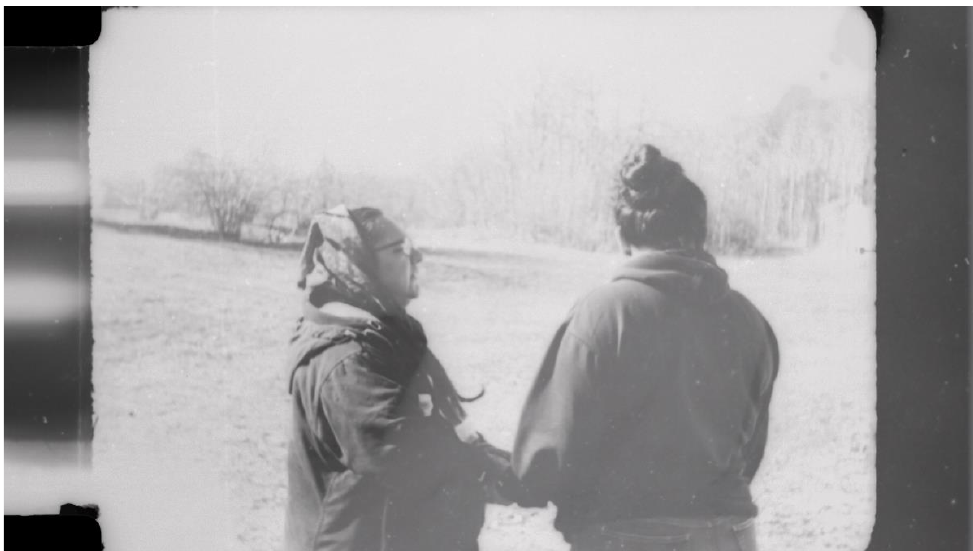
Figure 1. Mother and daughter holding hands, The Ancestors’ Gift